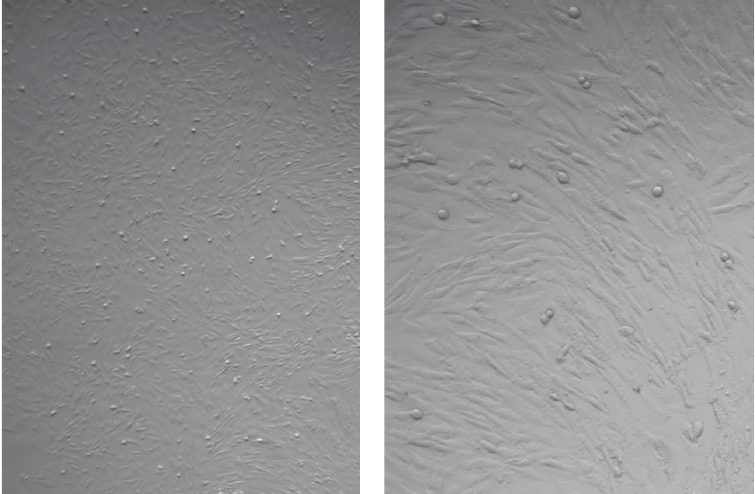
Figure 1: Bovine bone marrow culture to propagate mesenchymal cells. Note that the culture comprises a subpopulation of spherical cells along with the MSCs. These small round cells are possibly the VSELs.